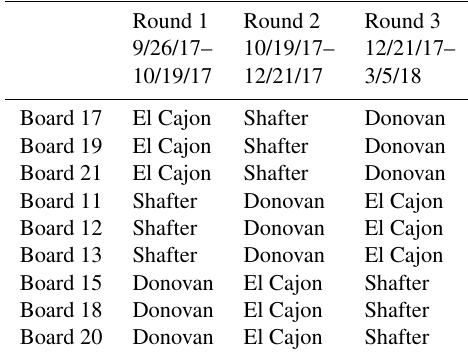
Table 1. Board locations and dates for each